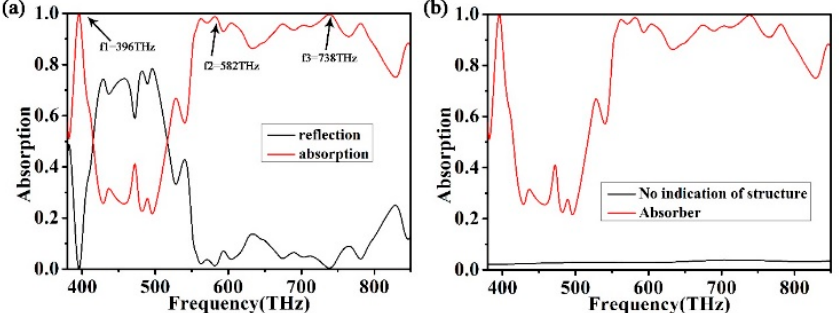
Figure 2. ( a ) Ultra-broadband spectrum of a solar absorber. ( b ) Spectrum of an absorber without surface structure.